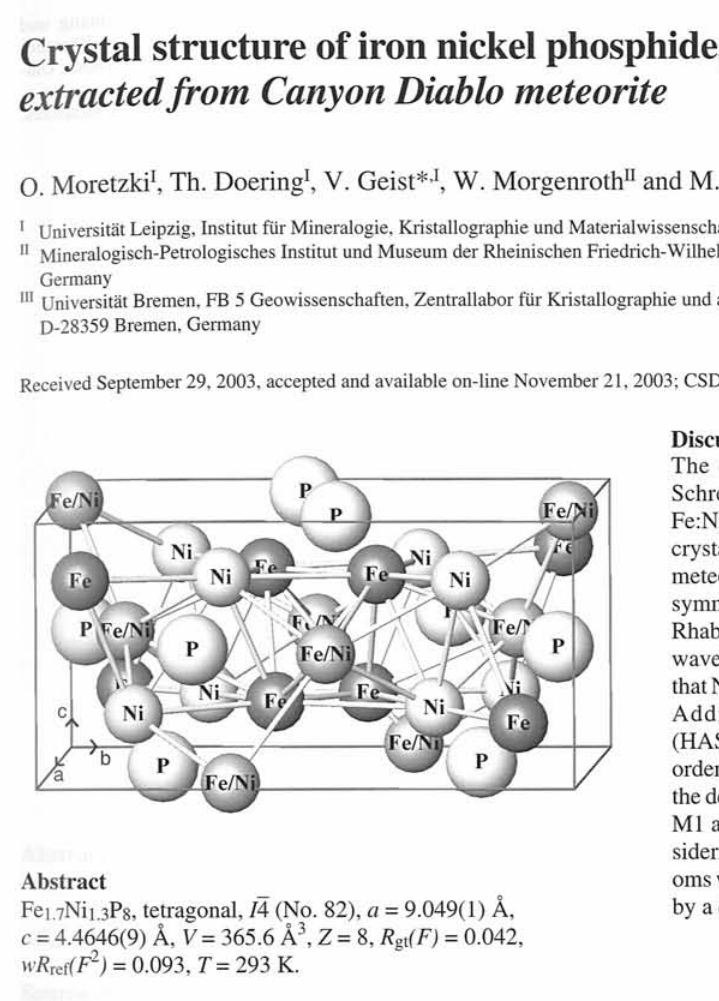
Table 1. Data collection and handling.